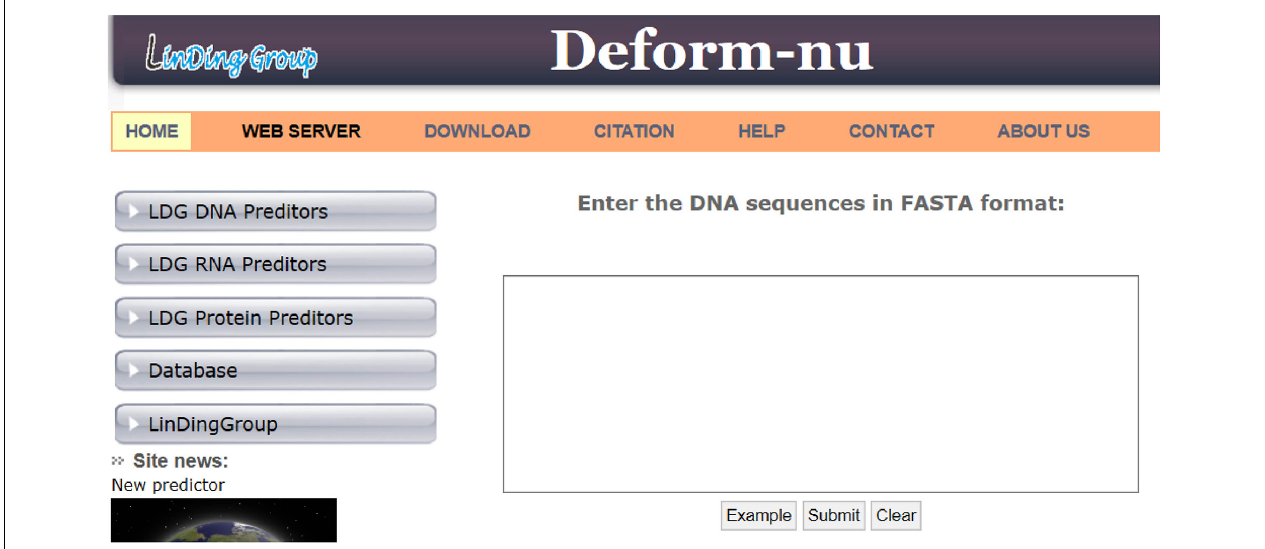
FIGURE 1 | A screenshot of the Deform-nu web server interface.